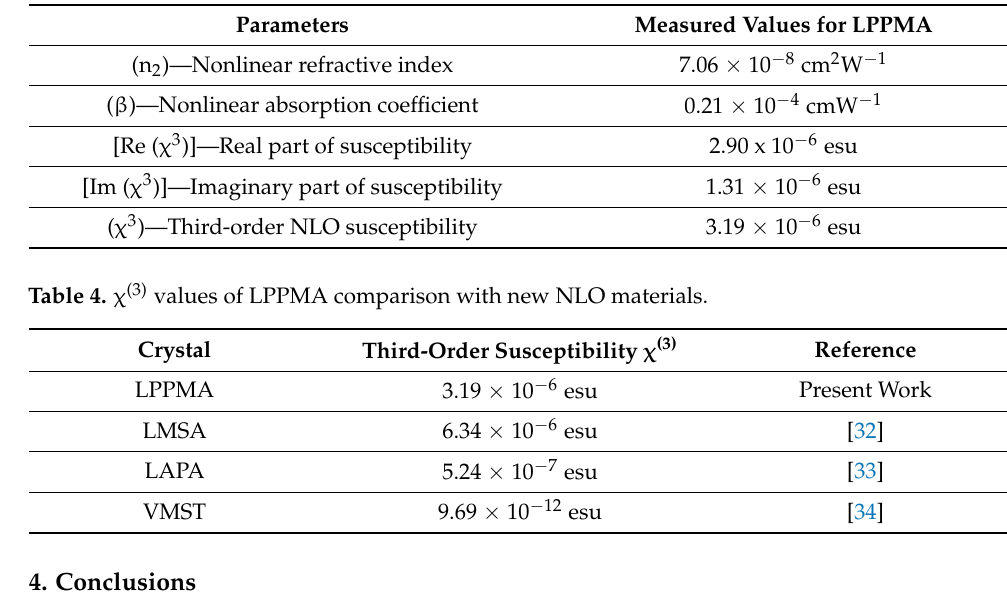
Table 3. Nonlinear optical parameters for LPPMA.